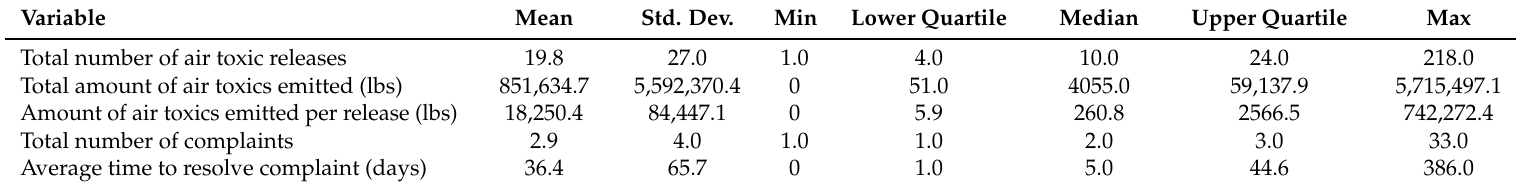
Table 1. Toxic Release Inventory (TRI) data (2006–2011) for Atlanta metropolitan statistical area (MSA) census tracts with TRI facilities ( N = 135).